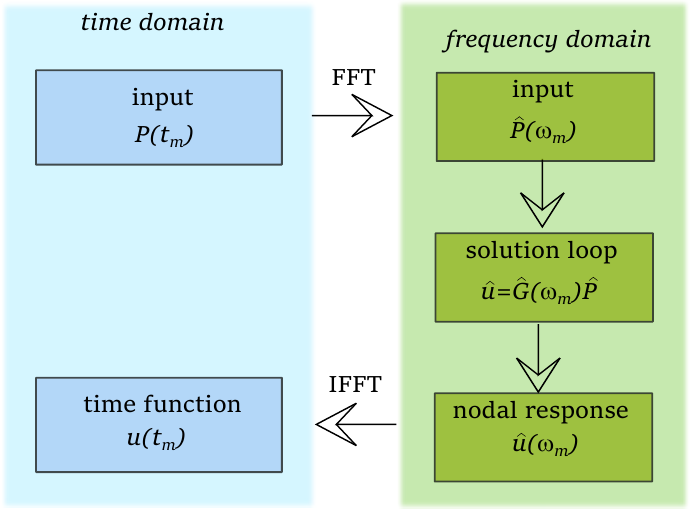
Figure 1. Flow diagram for a signal reconstruction procedure with